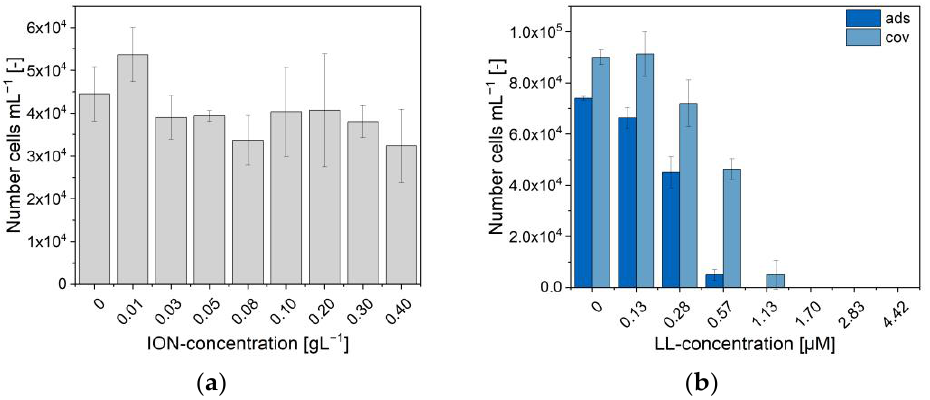
Figure 7. Growth of E. coli (BL21 (RH)4GFP-expressing) in M9 medium at different ( a ) ION@CMD12.5 concentrations and ( b ) amounts of the ION@CMD@LL complex obtained through adsorption and covalent binding. The concentration of ION@CMD@LL in diagram B describes the LL concentration.